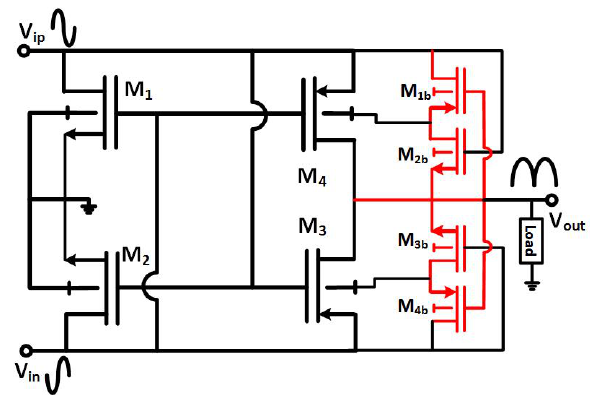
Figure 4: Bulk-regulated differential drive (Cross- connectd) CMOS rectifier